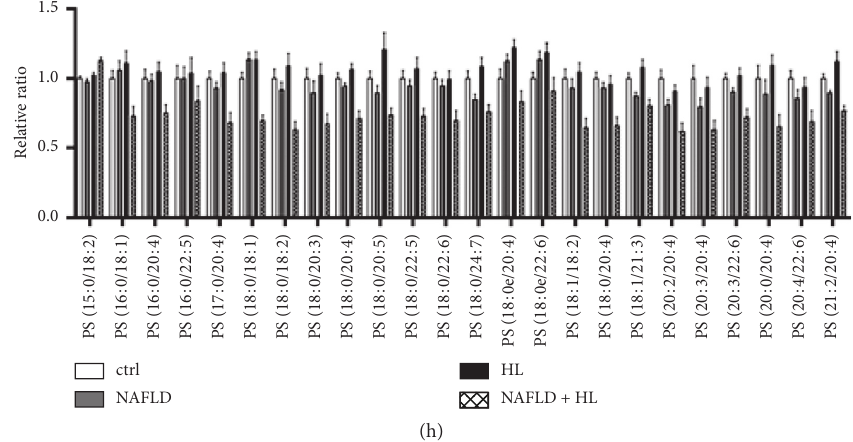
Figure 2: Comparison of the contents of total PI (a), PC (b), PE (c), and PS (d), relative ratio of individual PI (e), PC (f), PE (g), and PS (h) in the erythrocyte membrane between four groups. Error bars represent the mean ± SD; ∗∗ p < 0 . 05, ∗∗ p < 0 . 01, ∗∗∗ p < 0 .